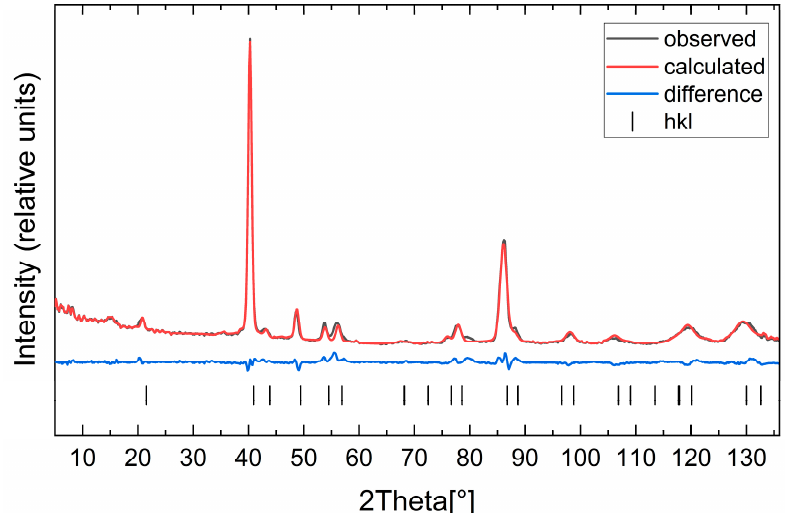
Figure 3. Rietveld refinement of the neutron powder diffractogram of Mn 1.8 Co 0.2 Sb at 550 K ( R obs = 6.56%, R wp = 5.07%, R p = 3.43%). The small peak at around 80° is not observed at the other temperatures and can most likely be attributed to an artifact. Table 2. Final agreement factors of the magnetic structure refinements for the Mn 1.8 Co 0.2 Sb (350K, RT,